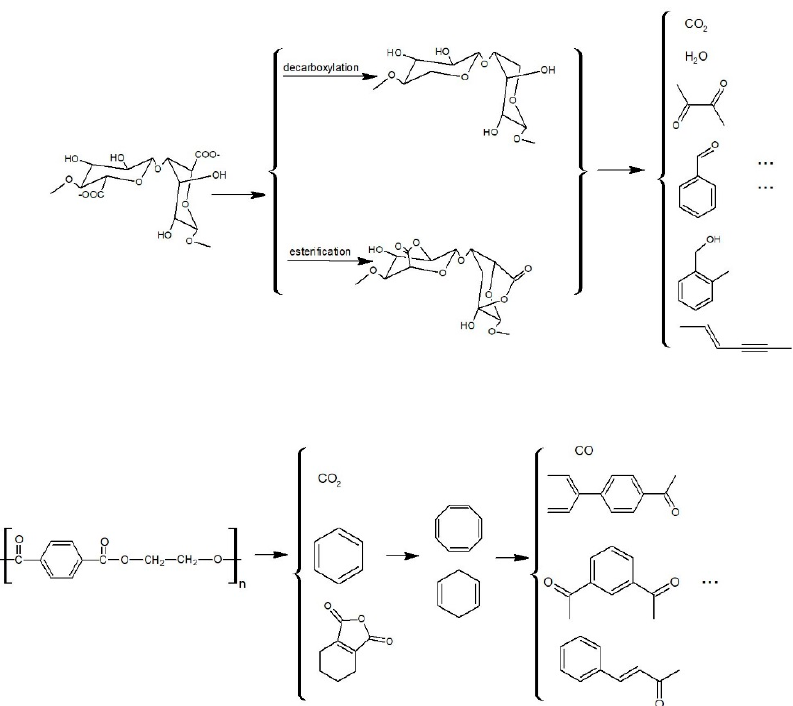
Figure 7. Proposed pyrolysis mechanisms of the CAB-PL.